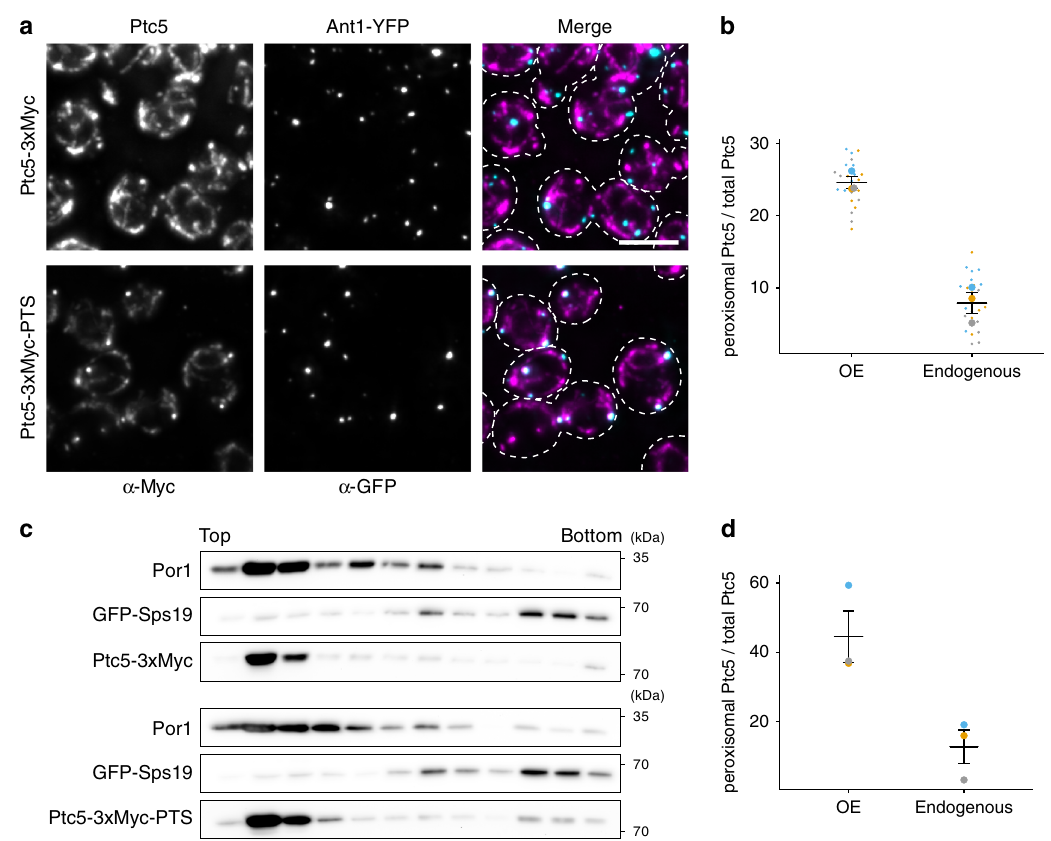
Fig. 2 Dual targeting of endogenously tagged Ptc5. a Yeast cells expressing either C-terminally (upper panel) or internally (lower panel) 3xMyc tagged Ptc5 (magenta) together with Ant1-YFP (cyan) were analyzed by immuno fl uorescence microscopy. Antibodies against Myc and GFP were used for detection. White color indicates colocalization in merged pictures. Scale bar represents 5 µ m. b The fraction of peroxisomal Ptc5 signal to total Ptc5 signal was quanti fi ed using ImageJ 59 . ‘ OE ’ indicates Ptc5-RFP-PTS under control of the tef1 promoter (Fig. 1c). ‘ Endogenous ’ refers to Ptc5-3xMyc-PTS ( a ). Data of three independent experiments ( n = 3; each color represents one experiment) were plotted. Error bars represent standard error of the mean. c